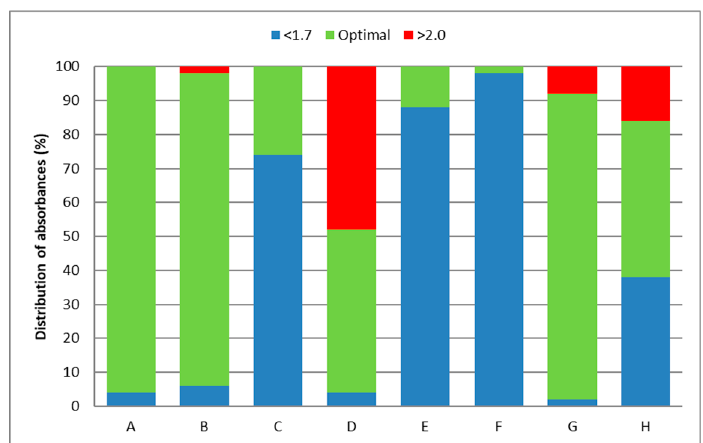
Figure 2. Distribution of A260/280 absorbance ratios; A—DNeasy Blood and Tissue Kit (Qiagen), B—DNeasy mericon Food Kit (Qiagen), C—Chemagic DNA Tissue 10 Kit (PerkinElmer), D—Food DNA Isolation Kit (Norgen Biotek), E—UltraPrep Genomic DNA Food Mini Prep Kit (AHN-Bio),